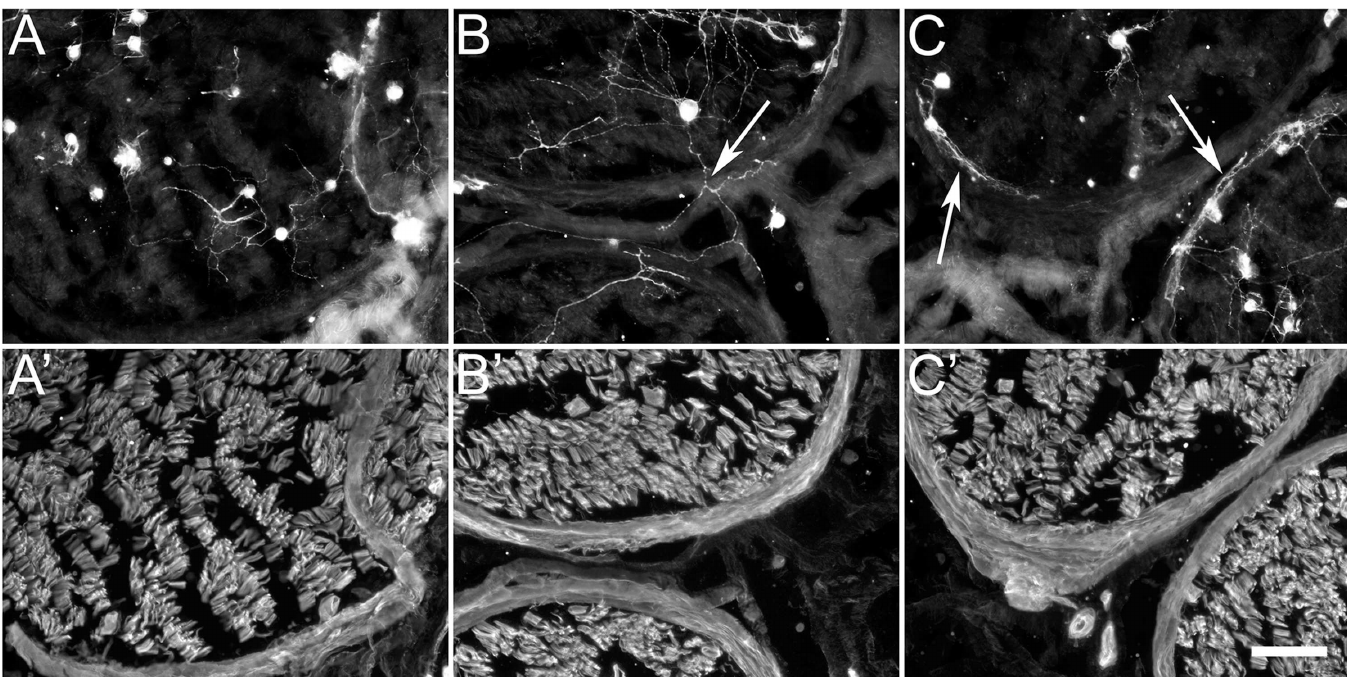
Fig 7. Cryoculture demonstrates differential functional effects from chondroitinase ABC and C treated nerve tissue. Normal human nerve was tranversely sectionedand treated with vehiclecontrol (A and A’), ChABC (B and B’), or chondroitinase C (C and C’) and subjectedto cryoculturebioassay. Cultures were doubleimmunolabeled for Gap43 (A, B, C) and laminin(A’, B’,C’). (A) Vehicle treated tissue sectionsprovideda poor substrate for neurite extentioneither within or outsidethe nerve fascicles. (B) ChABC treated tissue significantly enhanced the ability for neurite extensionand arborization within the nerve fascicles. Furthermore, neurites readily cross the perineurialand epineurialtissue to extend neurites from one fascicle to another (B arrow). (C) ChC treatment moderately improvedneuritic growth throughoutthe endoneurium. Interestingly, neurites did not cross the perineuriumsurroundingthe fascicles (C arrows) indicating that ChC selectivelyremovedendoneurial inhibitoryproteoglycan glycosaminoglycanchains whileretainingthe inhibitorypropertiesof the perineurium and epineurium. (A’, B’, C’) Lamininimmunolabeledtissue demarkated nerve fascicles. Scale bar: 100 μ m.